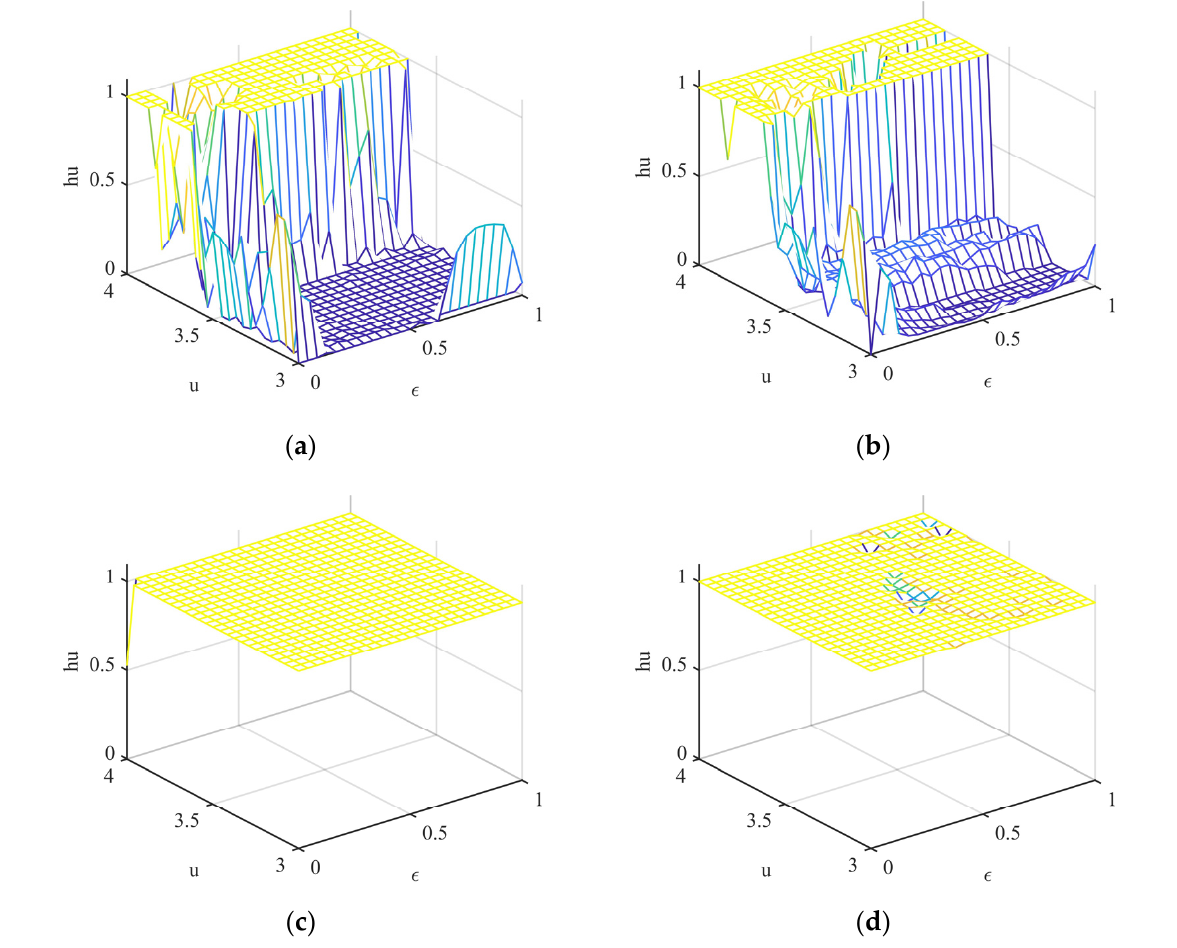
Figure 5. KEBs of ( a ) 2D-CML, ( b ) 2D-NLCML, ( c ) 2D-MCPML and ( d ) 2D-DPRCML.